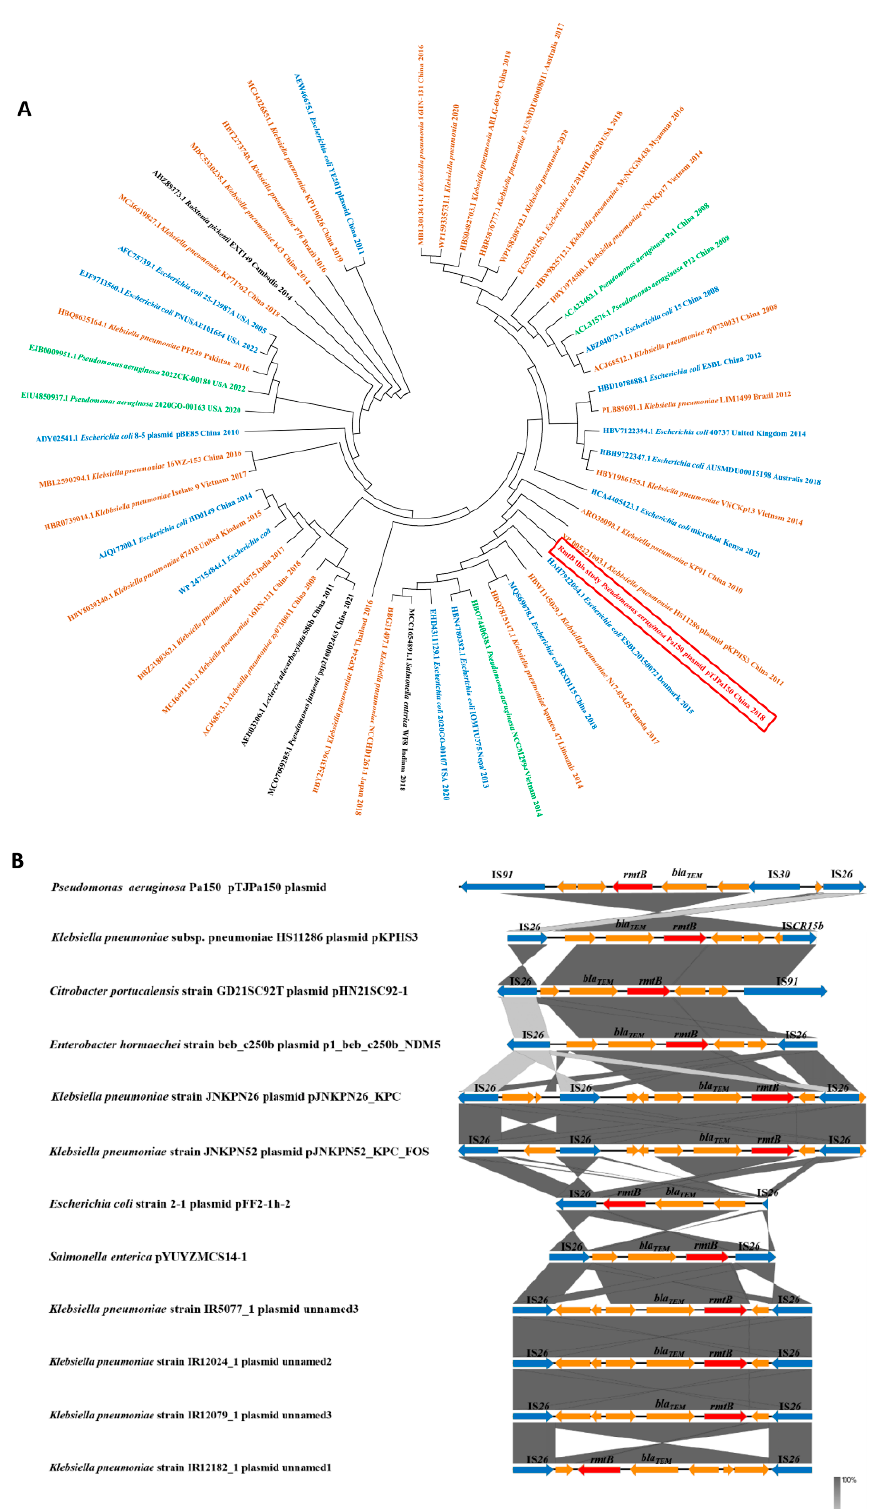
Figure 3. Phylogenetic tree and genetic information of rmtB . ( A ) Phylogenetic tree of RmtB and RmtB-like proteins. Neighbor-joining tree based on the amino acid sequences of RmtB and RmtB-like proteins (obtained from the NCBI databases) generated using MEGA7; the bootstrap was 1000. The bacteria species are indicated by the colors as follows: P. aeruginosa , green; K. pneumonia , orange; E. coli , blue; others, black. ( B ) Comparison of the genetic environment of rmtB with those of closely related sequences. The mobile genetic elements are shown in